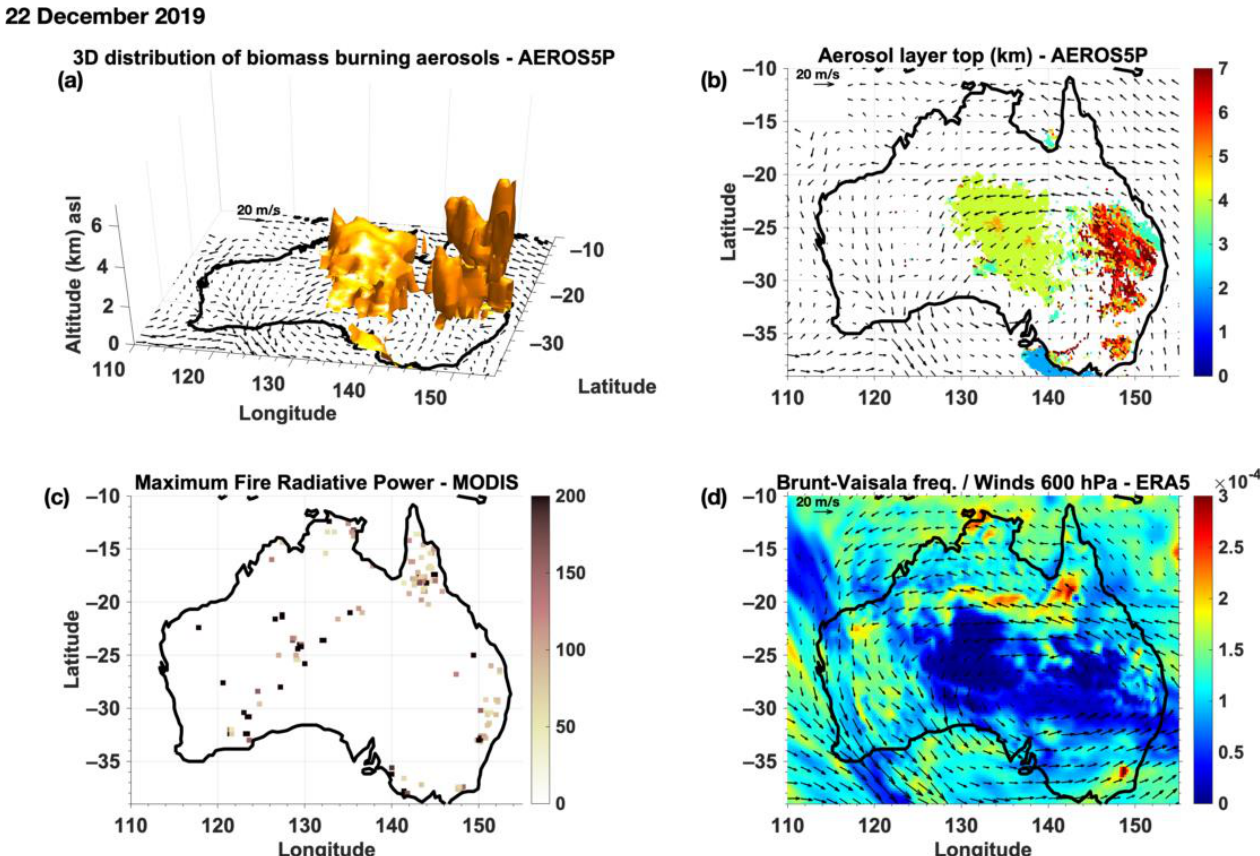
Figure 8. Same as Figure 6 but for 22 December 2019.